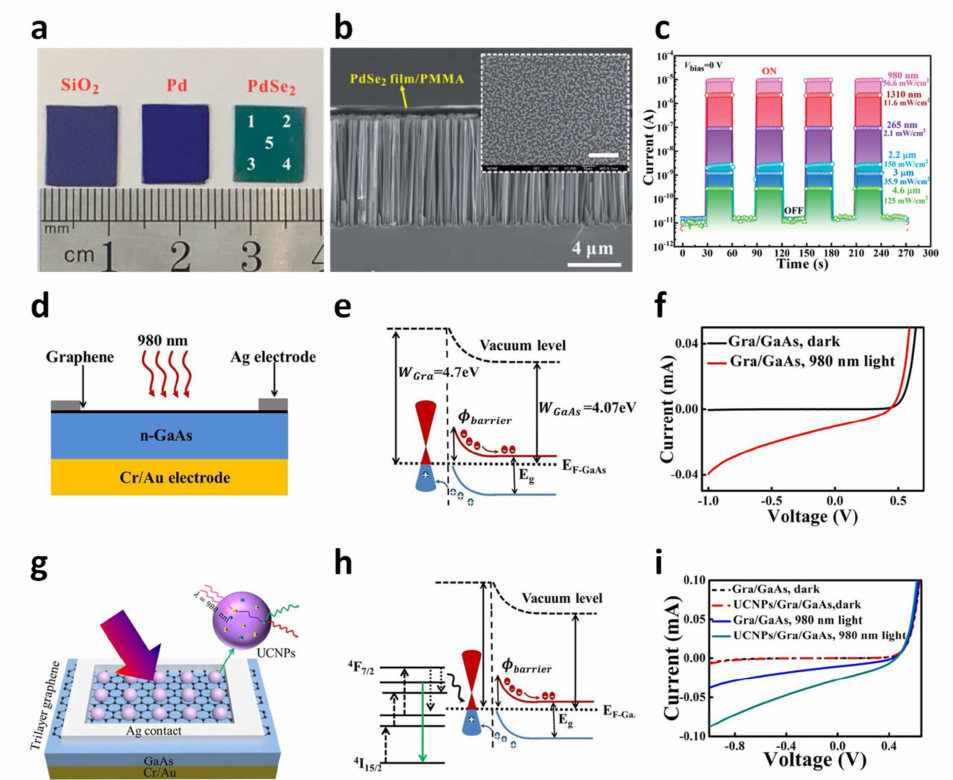
Figure 3. ( a ) Photographs of the SiO 2 /Si substrate, a Pd film, and a PdSe 2 film formed on the SiO 2 /Si substrate. ( b ) Cross-sectional SEM image of a PdSe 2 heterostructure vertically stacked on SiNWA. The inset shows a top view image of the heterogeneous structure. ( c ) Time vs. photocurrent plot of PdSe 2 /SiNWA heterostructure devices under illumination at different wavelengths (from 980 nm to 4.6 µ m) at V bias = 0 V. Reproduced with permission from [63]. Copyright 2020, Royal Society of Chemistry. ( d ) A cross-section view of a graphene/GaAs photodetector. ( e ) Electronic band alignment of the graphene/GaAs heterojunction. ( f ) I-V behavior of the graphene/GaAs photodetector in the dark (black) and under illumination from a 980 nm laser (red). ( g ) Top view of a graphene/GaAs photodetector coated with UCNPs. ( h ) Electronic band diagram of the UCNP/graphene/GaAs structure. ( i ) I-V behavior of graphene/GaAs or UCNP/graphene/GaAs photodetectors in the dark and under illumination from a 980 nm laser. The light illumination power is 55 mW.